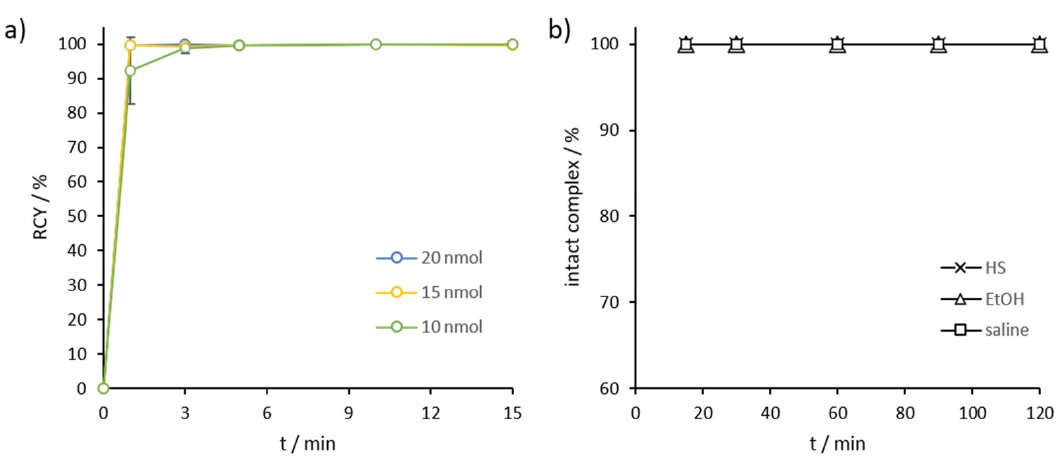
Figure 3. ( a ) Kinetics of [ 68 Ga]Ga-AAZTA 5 .SA.FAPi at RT for tracer amounts ≥ 10 nmol ( n = 3); ( b ) Stability of [ 68 Ga]Ga-AAZTA 5 .SA.FAPi at 37 °C in HS, EtOH, and NaCl over a period of 120 min ( n = 3).